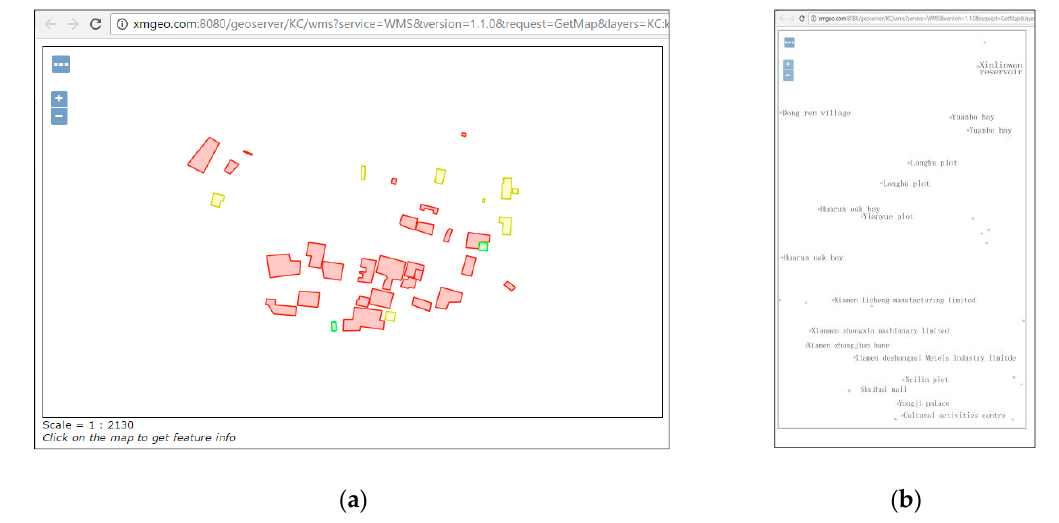
Figure 10. Layer modification of ( a ) the vector layer group and ( b ) the label layer.